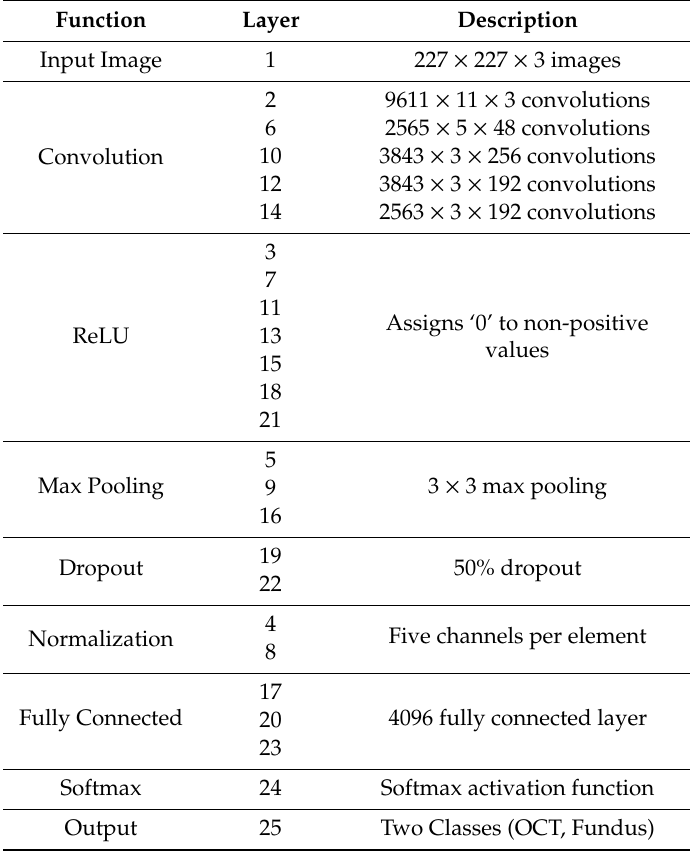
Table 2. Function wise details of the AlexNet